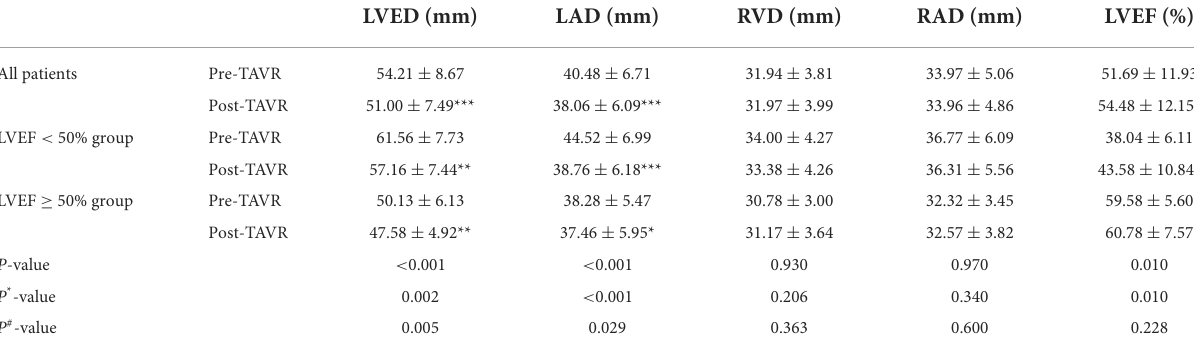
TABLE 3 Echocardiographic data at baseline and the end of the study.